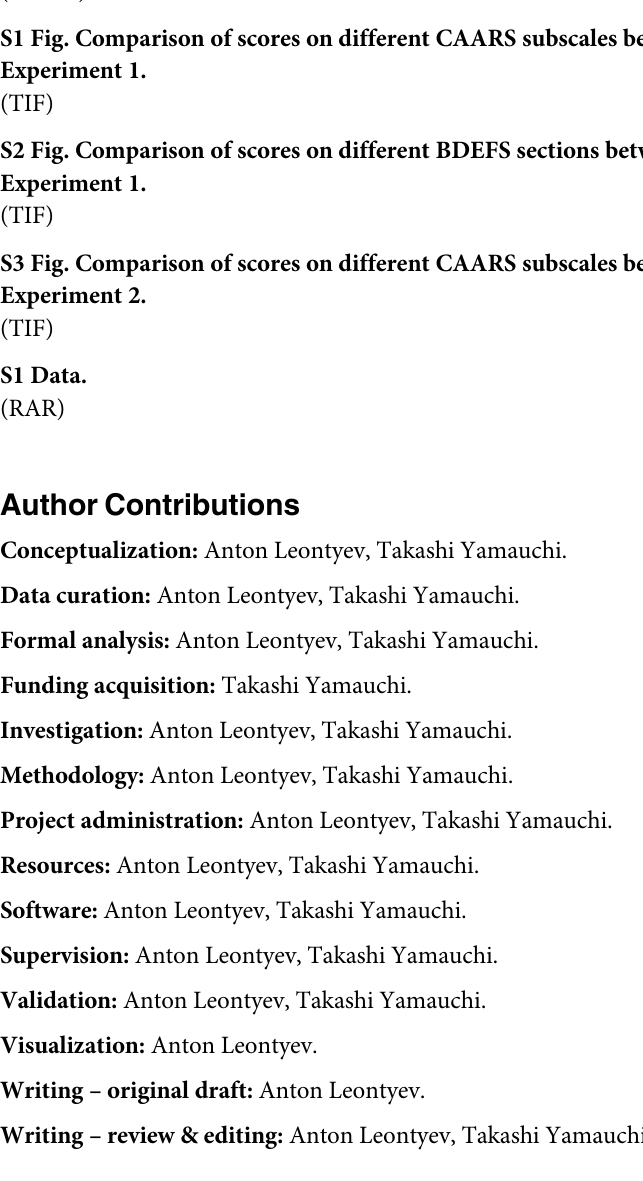
S1 Fig. Comparison of scores on different CAARS subscales between two conditions in Experiment 1. S2 Fig. Comparison of scores on different BDEFS sections between two conditions in Experiment 1. S3 Fig. Comparison of scores on different CAARS subscales between two conditions in Experiment